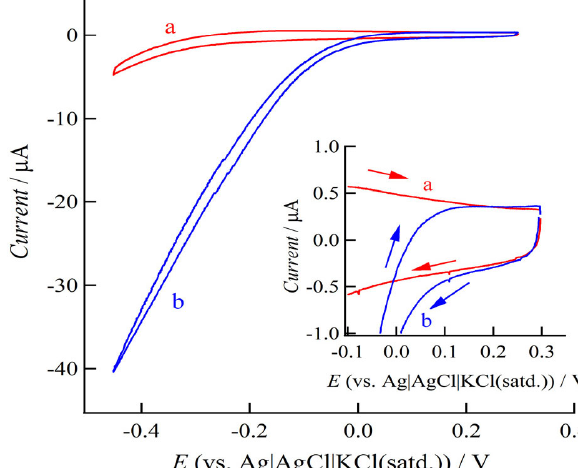
O and 5 µM Hb solution. Inset shows an 2 2 O reduction potential. Sweep rate is 0.01 V s − 1 2 2